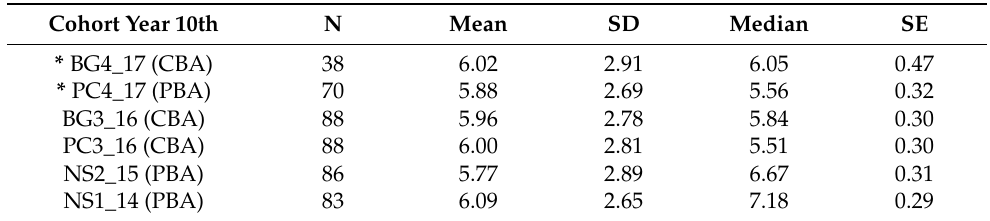
Table 3. Descriptive stats of EOC raw grades earned in mandatory and optional (*) science subjects studied by the students of cohort Year 10